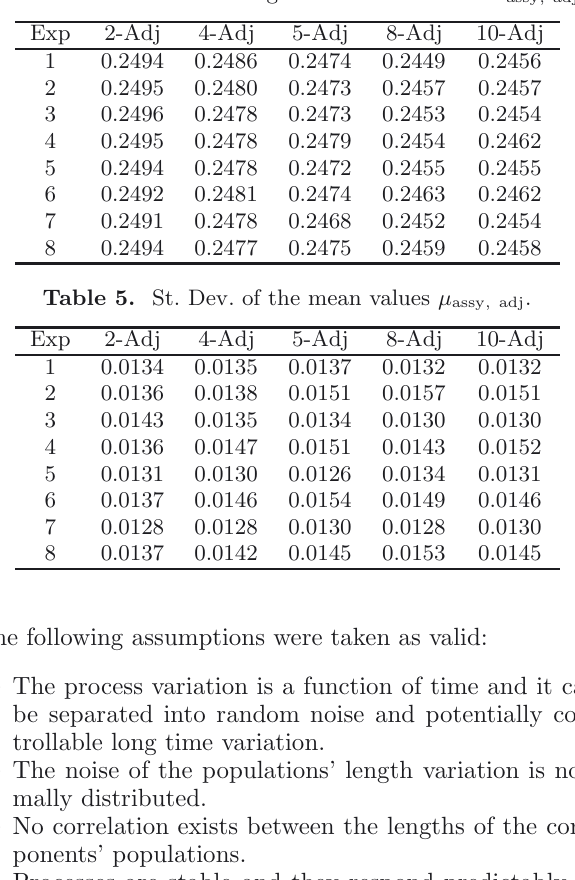
Table 4. Assemblies’ average standard deviation ¯ σ assy , adj .